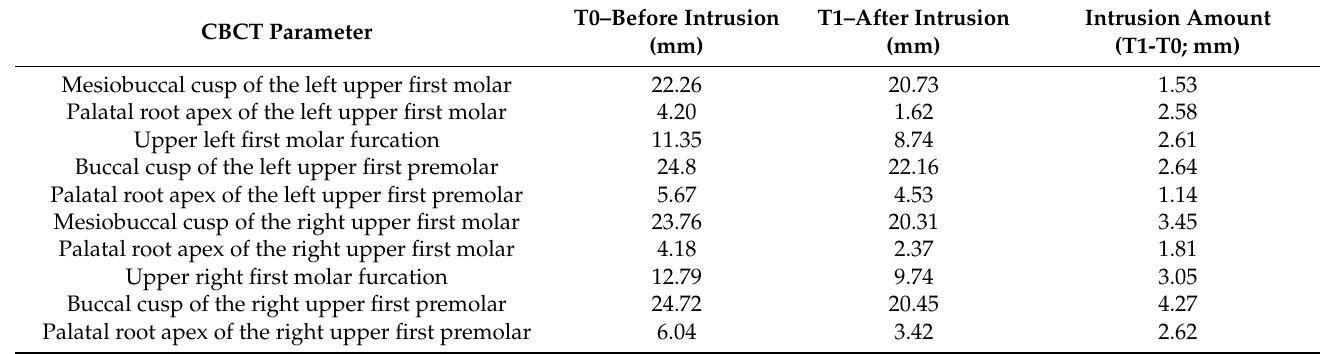
Table 4. The CBCT measurements before and after intrusion at the level of upper first molar and upper first premolar.